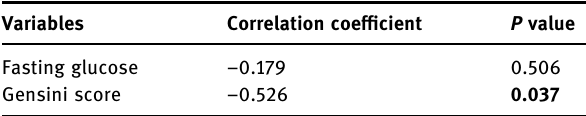
Table 3: Pearson correlation coe ffi cients between visfatin and fasting glucose or gensini score in IFG subjects Variables Correlation coe ffi cient Fasting